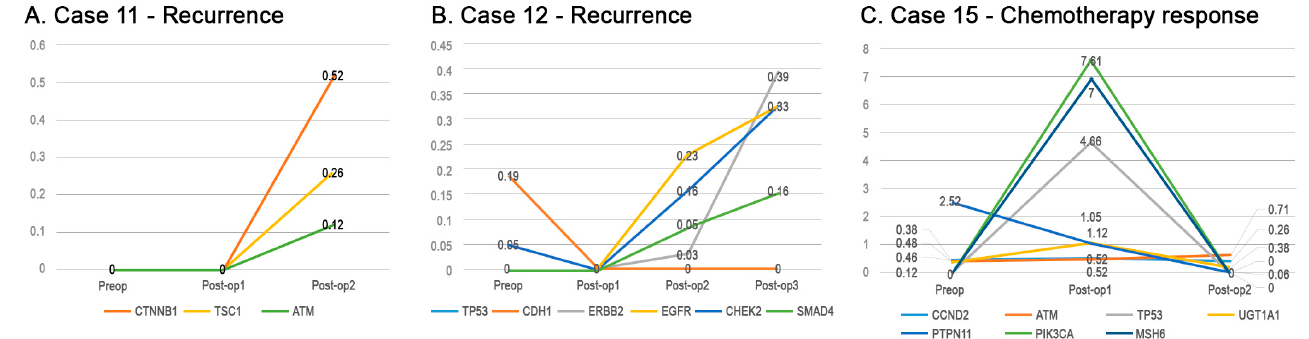
Figure 6. ctDNA detection in patients with mixed clinical responses: disease progression in ( A , B ) patients with recurrence and ( C ) a patient who responded to chemotherapy.